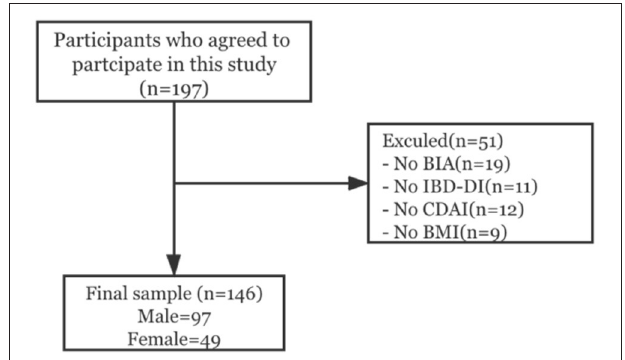
FIGURE 1 | Flow chart of patients included in the